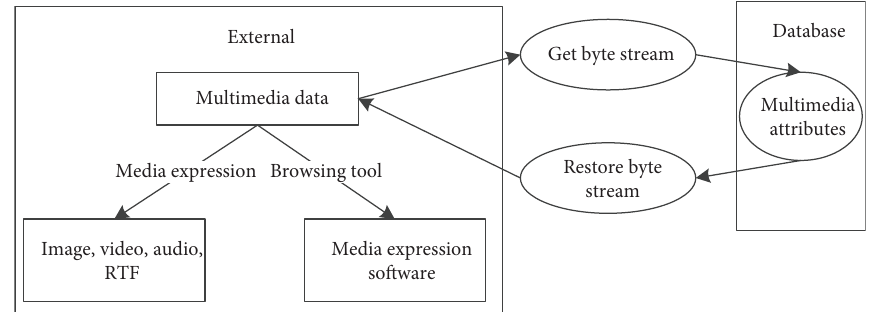
Figure 3: Access attribute process of multimedia data processing.